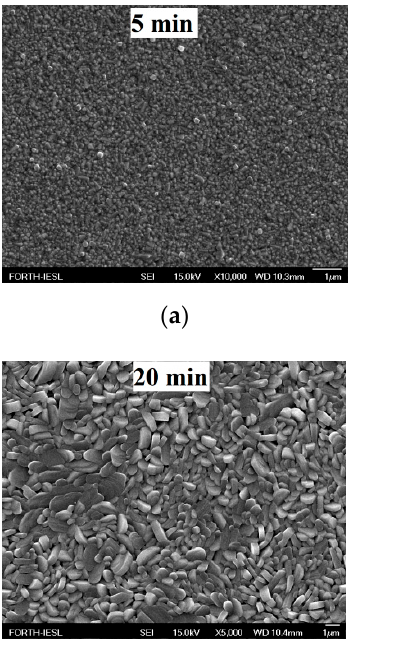
Figure 4. ( a ) Current-potential curves of the V 2 O 5 grown by AACVD at 400 °C for a growth period of 1 h and annealed at 600 °C for 3 h and ( b ) the FE-SEM images of the sample; ( c ) XRD pattern of the sample.